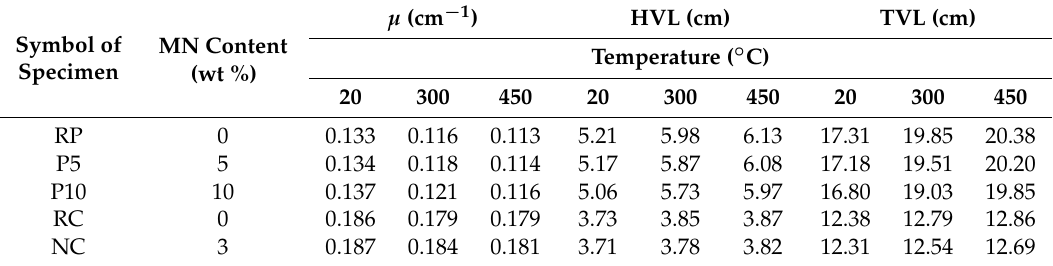
Table 4. The results of testing the shielding properties of cement pastes and concretes.